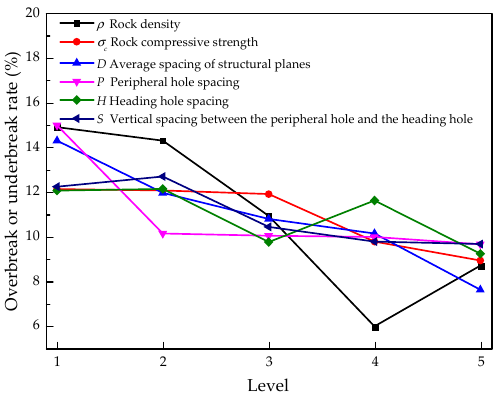
Figure 14. Overbreak or underbreak rate of smooth blasting under different levels of each factor in the cataclastic structure rock